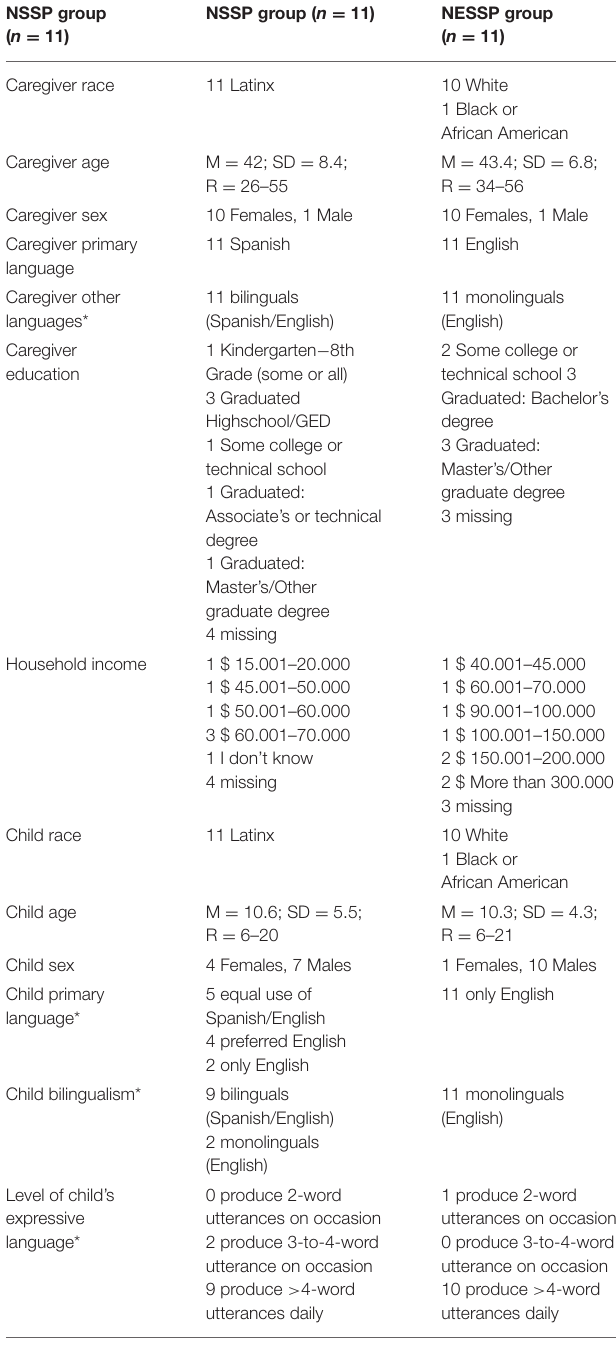
TABLE 1 | Demographics and language-related characteristics of